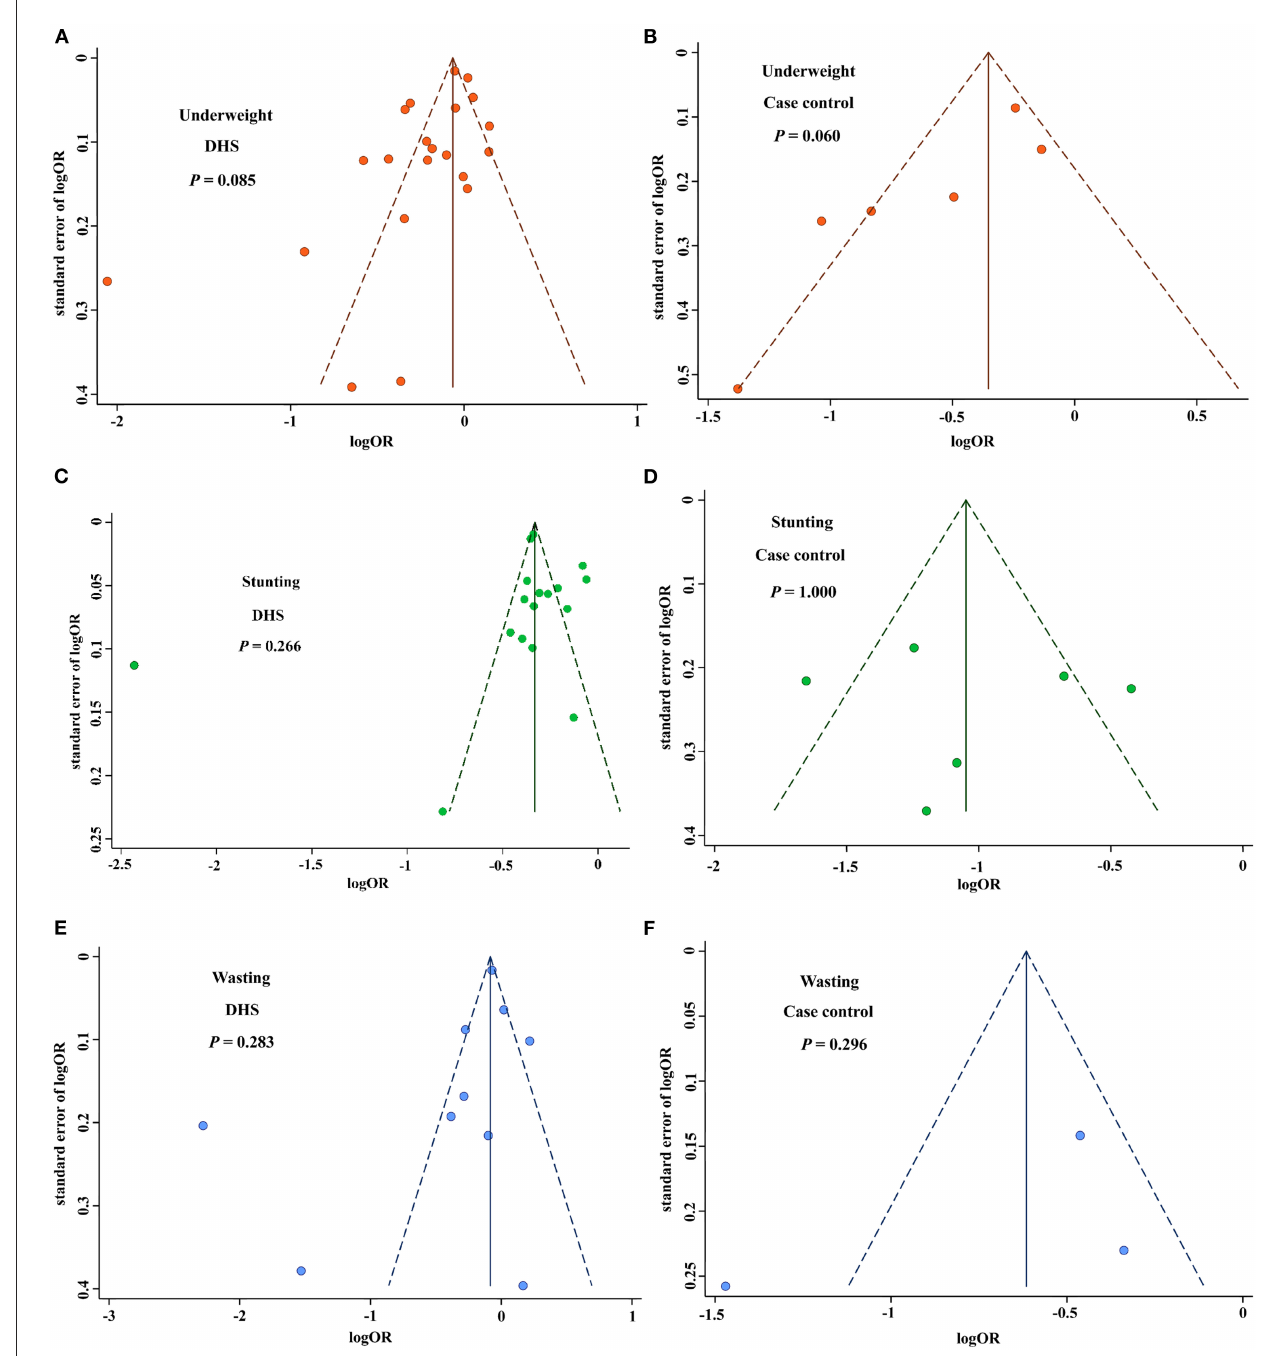
FIGURE6 Funnel plot for publication bias of birth interval and childhood nutrition outcomes. (A) Funnel plot for publication bias of underweight based on the DHS studies. (B) Funnel plot for publication bias of underweight based on the case-control studies. (C) Funnel plot for publication bias of stunting based on the DHS studies. (D) Funnel plot for publication bias of stunting based on the case-control studies. (E) Funnel plot for publication bias of wasting based on the DHS studies. (F) Funnel plot for publication bias of wasting based on the case-control studies. DHS, demographic health